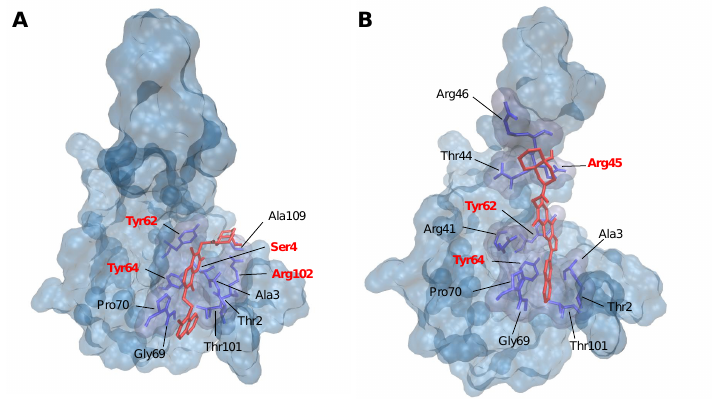
Figure 8. Molecular docking of ( A ) compound ( 1 ) and ( B ) compound ( 4 ) binding to SARS-CoV-2 NP NTD (PDB:6M3M). Red marked residues represent conserved amino acids in the sequence alignment.